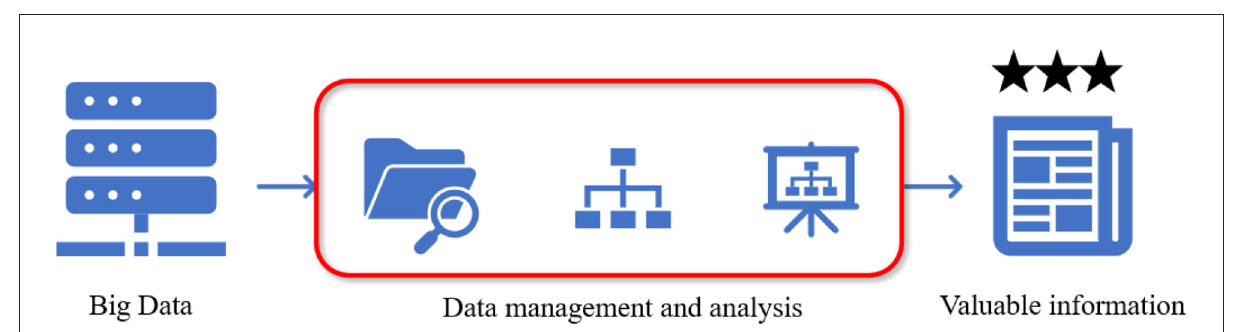
FIGURE6 TEA of IoT vs. non-IoT infrastructure.